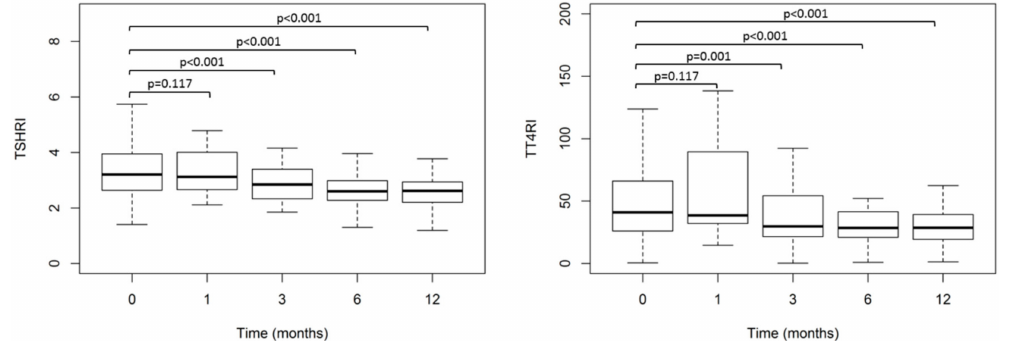
Figure 2. Evolution over time of Thyrotroph T4 resistance index (TT4RI) and TSH index (TSHRI) values (Median (IR)) before and after surgery (0, 1, 3, 6, and 12 months) in obese patients ( n =